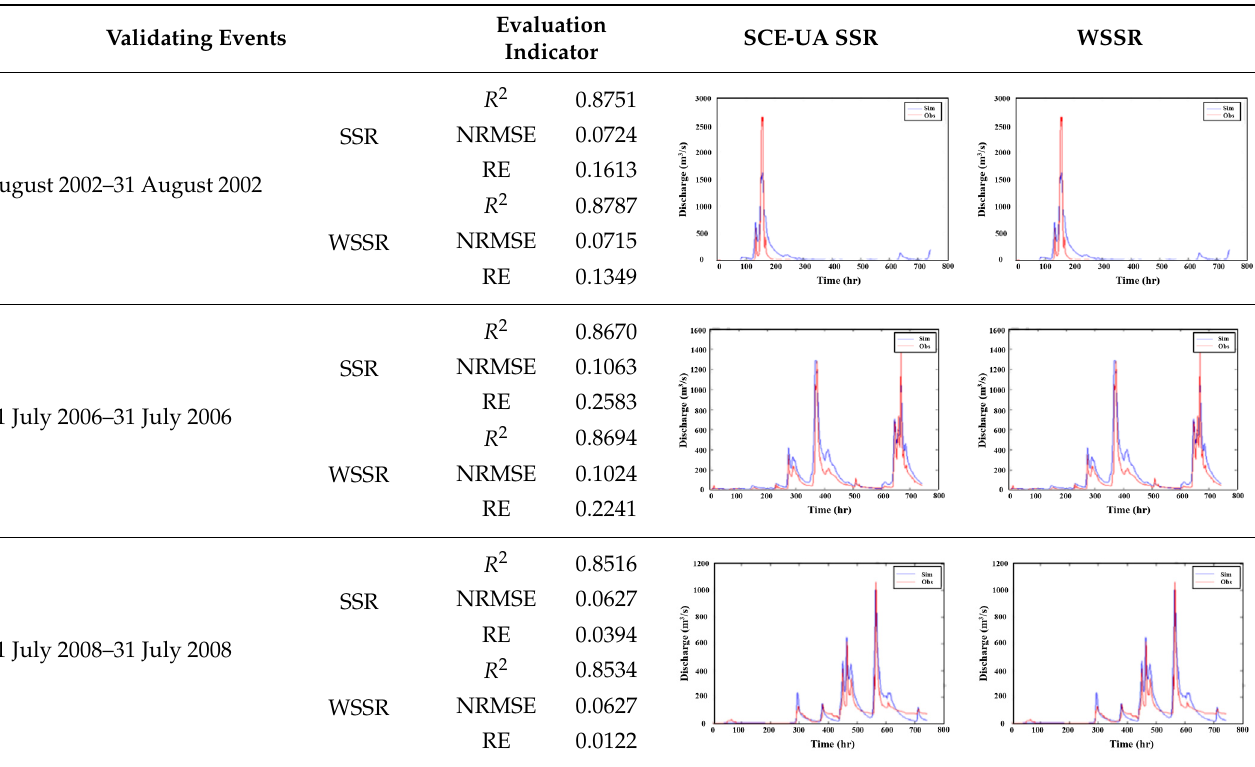
Table 3. Validation of the model using objective functions.